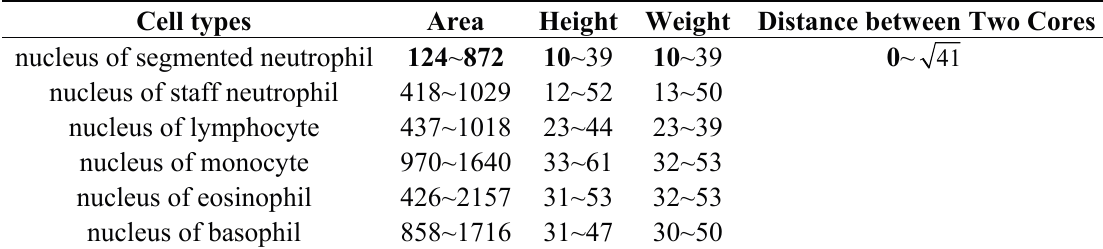
Table 2. Characteristic parameters of the